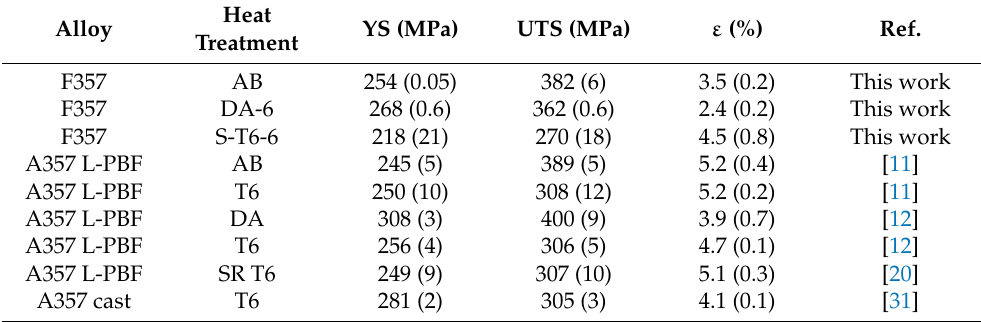
Table 3. Tensile properties of F357 and A357 produced by L-PBF and conventional processing.